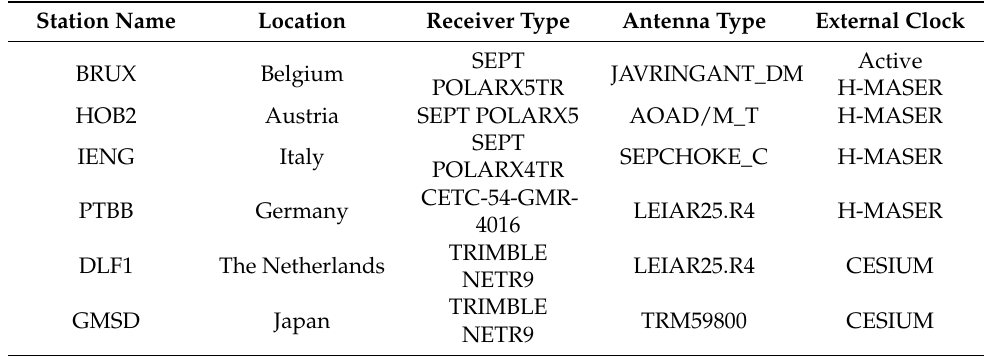
Table 1. Station information involved in the experiment.